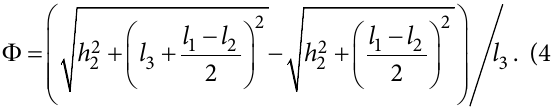
of composite slabs: y